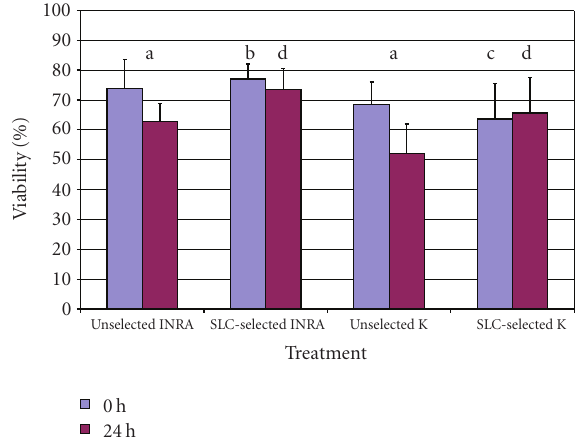
Figure 5: E ff ect of Single Layer Centrifugation through Androcoll- E on mean stallion sperm viability ( n = 45). Note: a:di ff erence in sperm viability at 0 and 24 hours was statistically significant for the uncentrifuged samples in both extenders; b: SLC-samples in INRA96 had a higher viability than non-SLC samples at 0 hour ( P < . 001); c: di ff erence between uncentrifuged and SLC-samples in Kenney’s extender at 0 hour, P < . 02; d: SLC samples in both extenders had a higher viability than the uncentrifuged samples at 24 hours ( P < . 001).